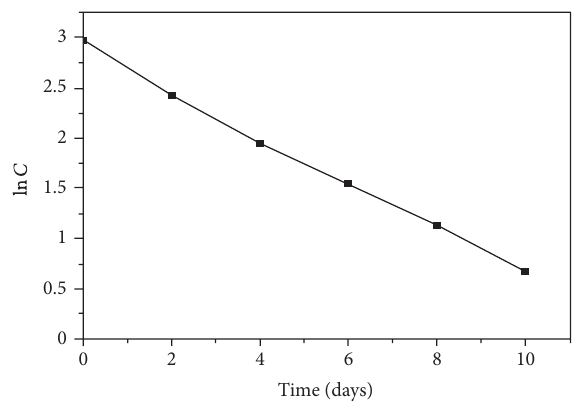
F 4: First-order kinetic model for chlorpyrifos degradation with ZVNI.